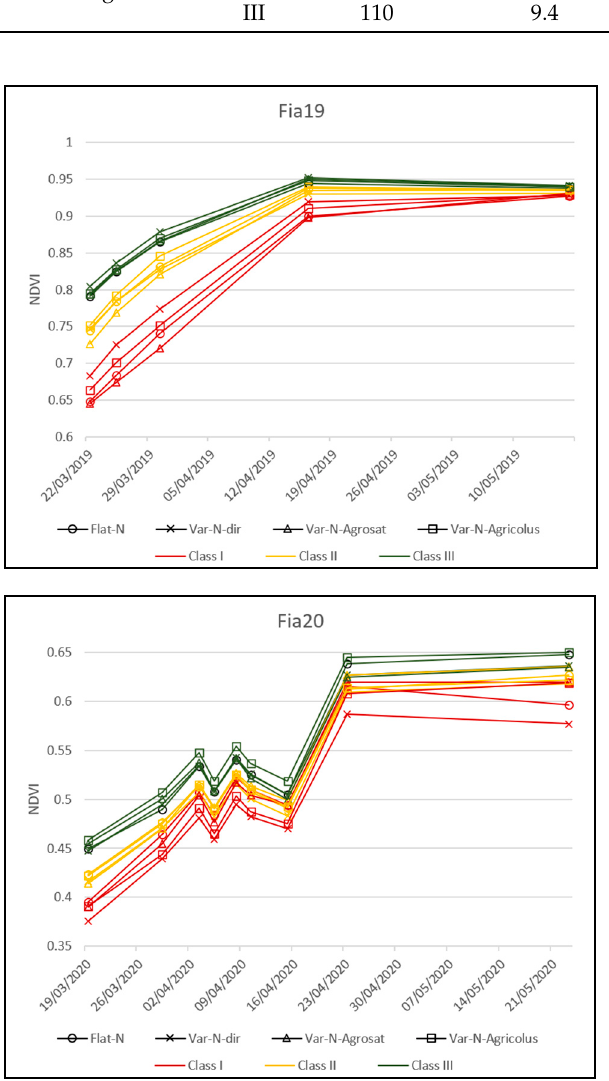
Figure 6. NDVI time series analysis, considering the three vigor classes (Class I: red lines; Class II: yellow lines; Class III: green lines) as identified in the S2 image from 22 March 2019 for Fia19 ( top ), and from 19 March 2020 for Fia20 ( bottom ).